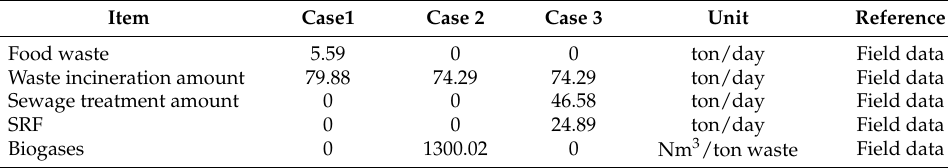
Table 12. Waste amount of Case 1, Case 2 and Case 3.